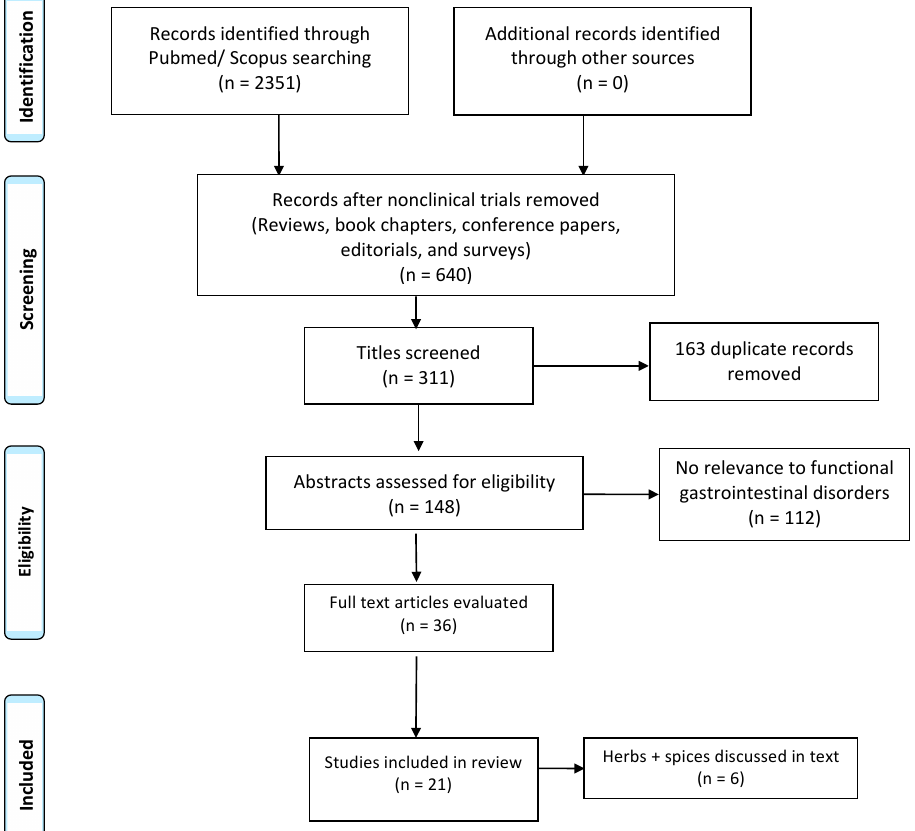
Figure 1. Literature search of herbs and spices in the treatment of functional gastrointestinal disorders.